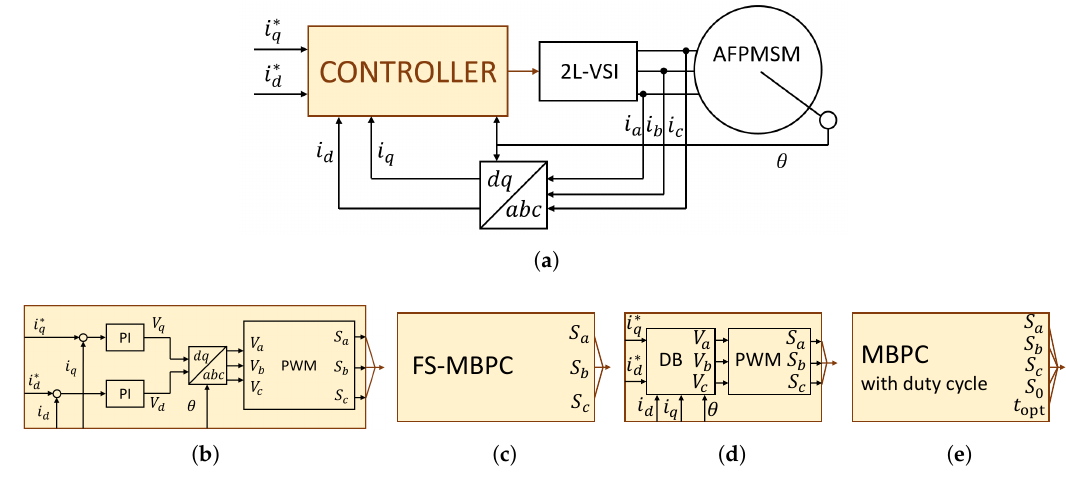
Figure 2. ( a ) General control scheme, with the four examined controllers: ( b ) PI control; ( c ) finite-set model based predictive control; ( d ) deadbeat control; ( e ) model based predictive control with duty cycle